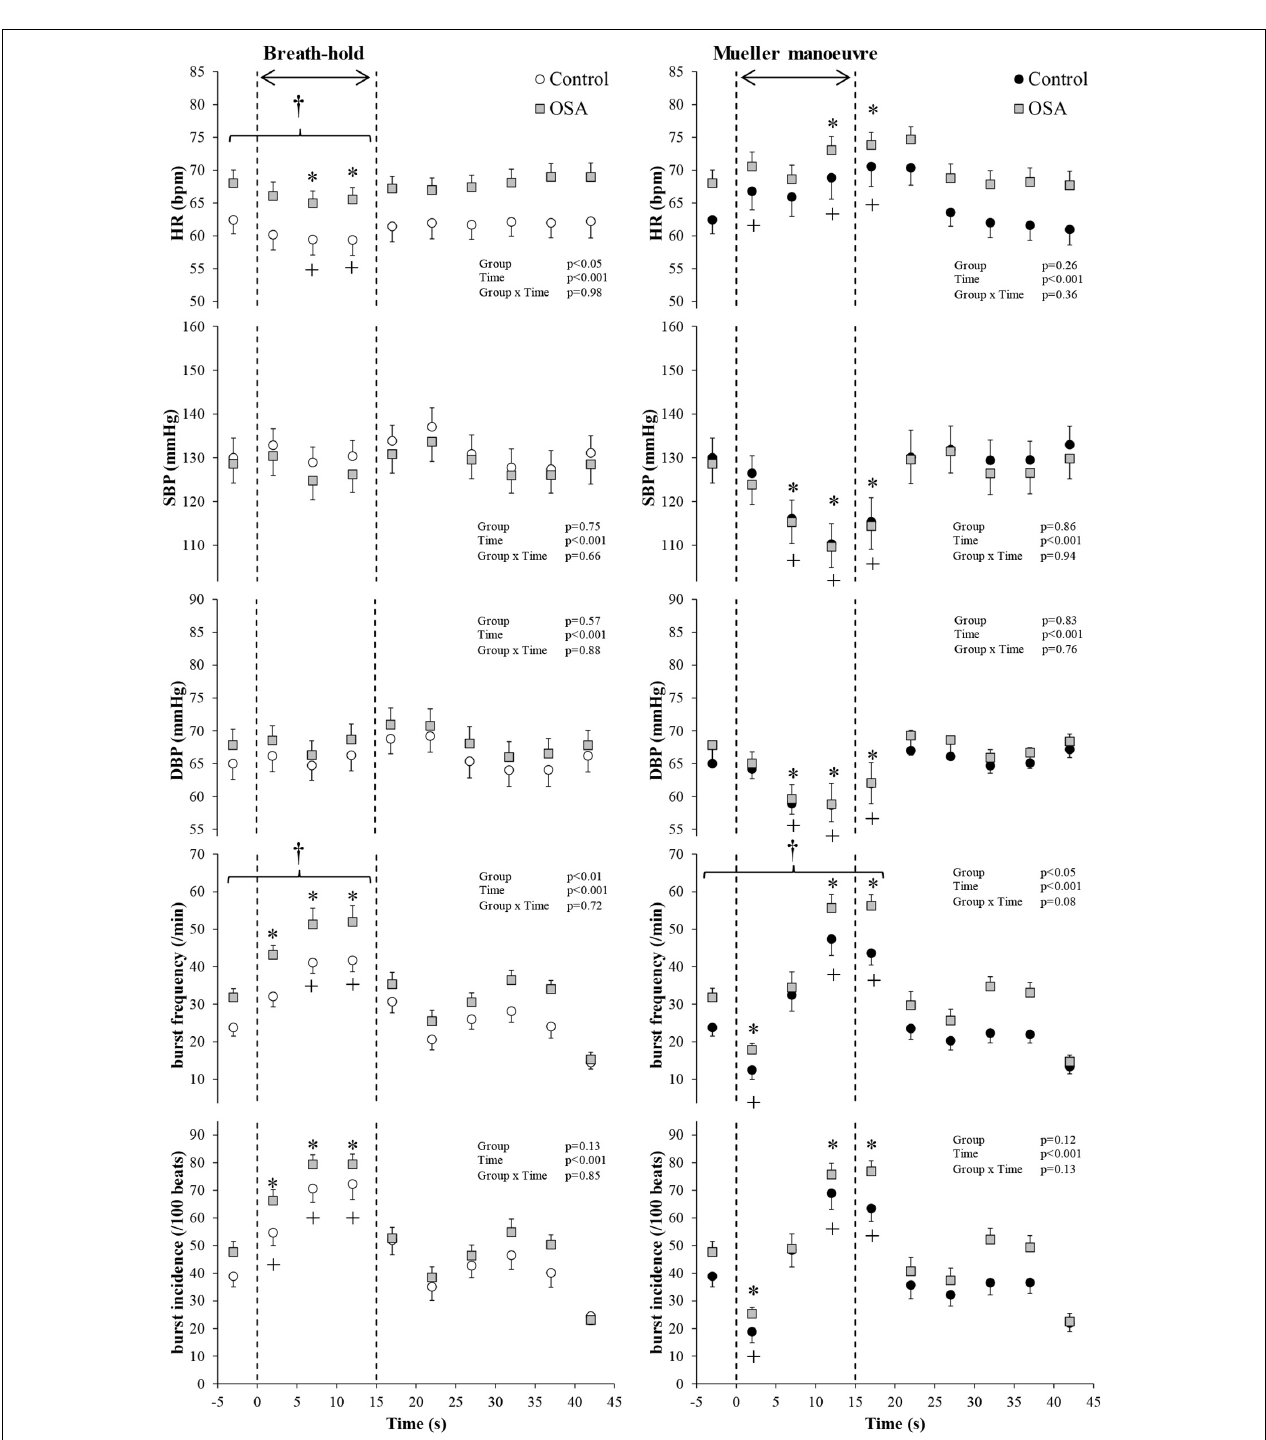
FIGURE 3 | All study participants. Mean ( ± 95% confidence limits) heart rate (HR), systolic and diastolic blood pressure (SBP and DBP), and muscle sympathetic nerve activity (MSNA) responses before, during, and after the series of 15 s of end-expiratory breath-holds ( left ) and 15 s of Mueller maneuvers ( right ) in 24 individuals with obstructive sleep apnea (OSA, gray squares) and 22 healthy controls ( white and black circles) are displayed. The dashed vertical lines indicate the beginning (time = zero) and end (time = 15 s) of both maneuvers. Continuous responses were bin-averaged at 5-s intervals. For breath-holds, data during the 15 s of the task were compared with baseline values. For Mueller maneuvers, due to the time delay preceding sympathetic excitation, data during the 15 s of the task plus the first 5-s interval following the task were compared with baseline values. † p < 0.05 compared to control group; ∗ p < 0.05 compared to pre-maneuver (i.e., − 2 s) in healthy controls; + p < 0.05 compared to pre-maneuver (i.e., − 2 s) in OSA.